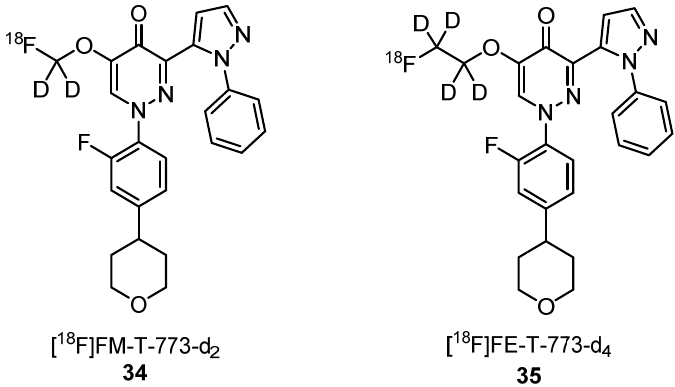
Figure 14. PET radiotracers 34 and 35 for in vivo phosphodiester-10A (PDE10A) evaluation in nonhuman primates’ brains [63].